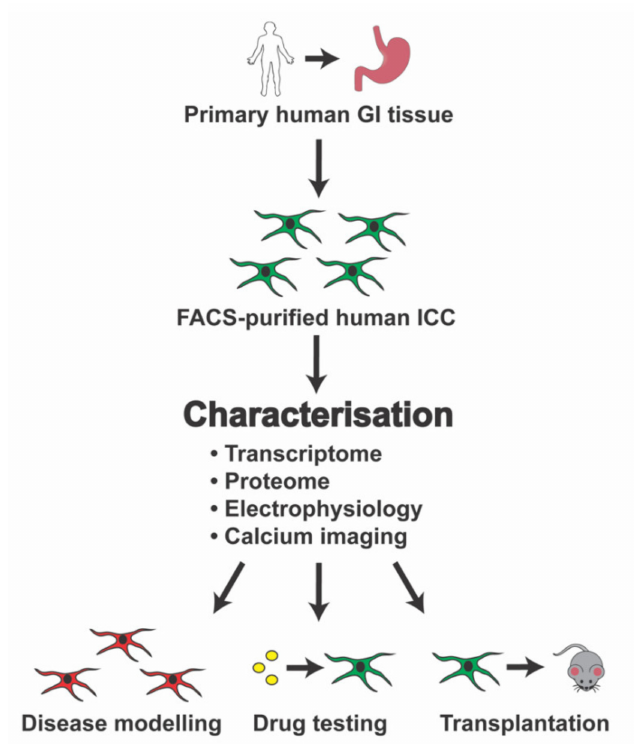
Figure 2. Workflow for characterisation of patient-derived human gastric interstitial cells of Cajal